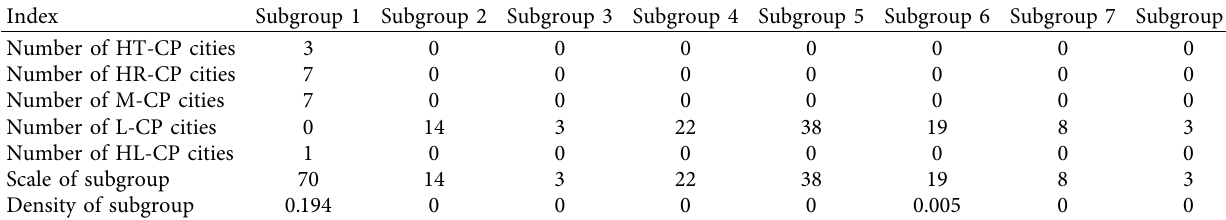
Table 6: Index identifying subgroup development stage.